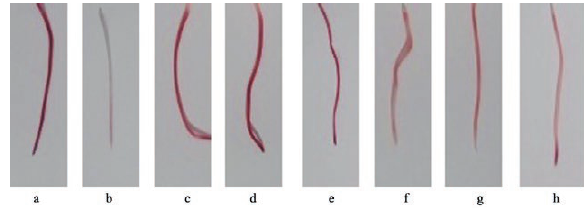
Figure 4. Analysis of metabolic activity using TTC staining of root of A. cepa . a=control, b=30 ppm Ni, c=100 ppm Ea, d=100 ppm Ea, d= 250 ppm Ea, e=500 ppm Ea, f=30ppmNi+100 ppm Ea, g=30 ppm Ni+250 ppm Ea, h=30 ppm Ni+500 ppm Ea. Ea=encapsulated E. acoroides leaves extract.